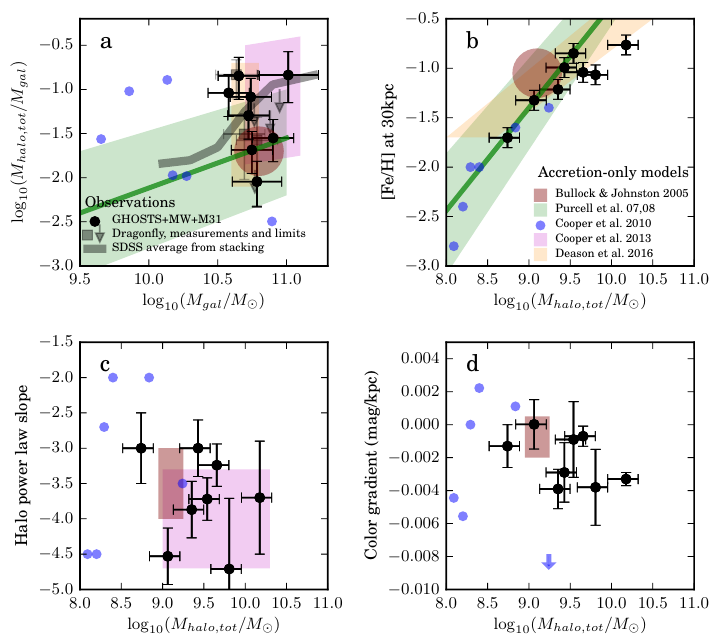
Figure 2. Both resolved star (black; [7,8,38,39,42–44]) and integrated light studies (gray; [36,45]) reveal a diversity of stellar halo masses, metallicities, density profiles, and metallicity gradients. These observational properties are in good agreement with models in which stellar halos are predominantly formed by the disruption of dwarf satellites (in colors). ( a ) Ratio of “total” stellar halo mass and total stellar mass, as a function of total stellar mass. Error bars include the uncertainty in extrapolating to “total” stellar halo mass; limits are shown with arrows. ( b ) Stellar halo metallicity at 30 kpc as a function of “total” stellar halo mass. ( c ) Inferred 3D minor axis stellar halo density power-law slope in the range 10–40kpc as a function of “total” stellar halo mass. ( d ) Stellar halo color gradient (a proxy for metallicity gradient) as a function of “total” stellar halo mass. The observational data are shown in black and grey. Models: brick red area: [4]; light green + line: [5,25]; blue: [6]; magenta: [26]; orange: [23]. Adapted from Figure 16 from [8], reproduced with permission.